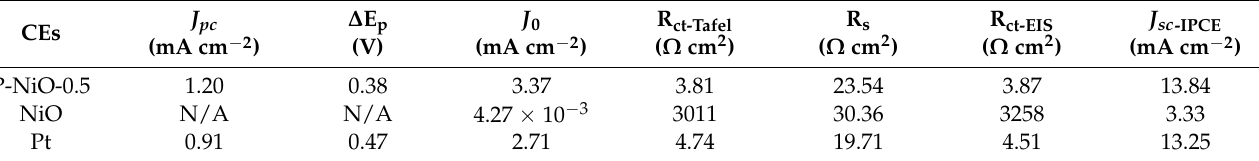
Figure 5. Cyclic voltammograms of P-NiO-0.5, NiO and Pt CEs at the scan rate of 100 mV/s. Table 3. Electrochemical parameters of the DSSCs with P-NiO-0.5, NiO and Pt